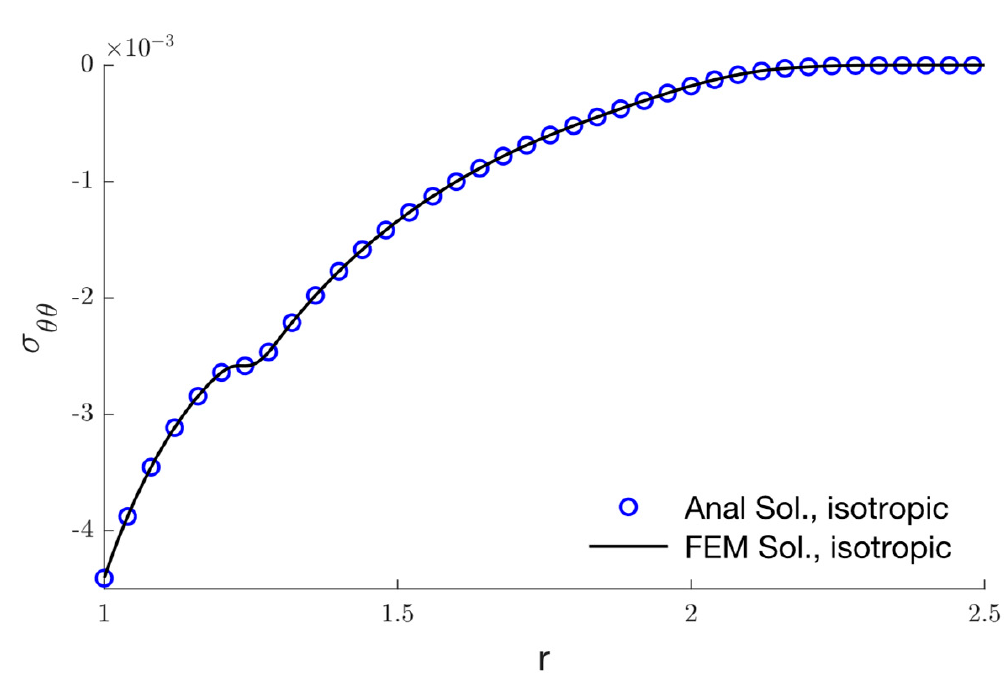
Figure 17. The shear stress variation σ (cid:3087)(cid:3087) θθ for isotropic material.